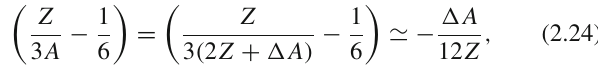
Fig. 2 The correlation coefficient ρ = (cid:13) ( f i − (cid:13) f i (cid:14) ) (cid:22) (cid:21) σ / σ between the the quark singlet (cid:12) and gluon g (solid red line), i j the quark octet T 8 and g (dashed blue line), and between (cid:12) and T 8 (dot-